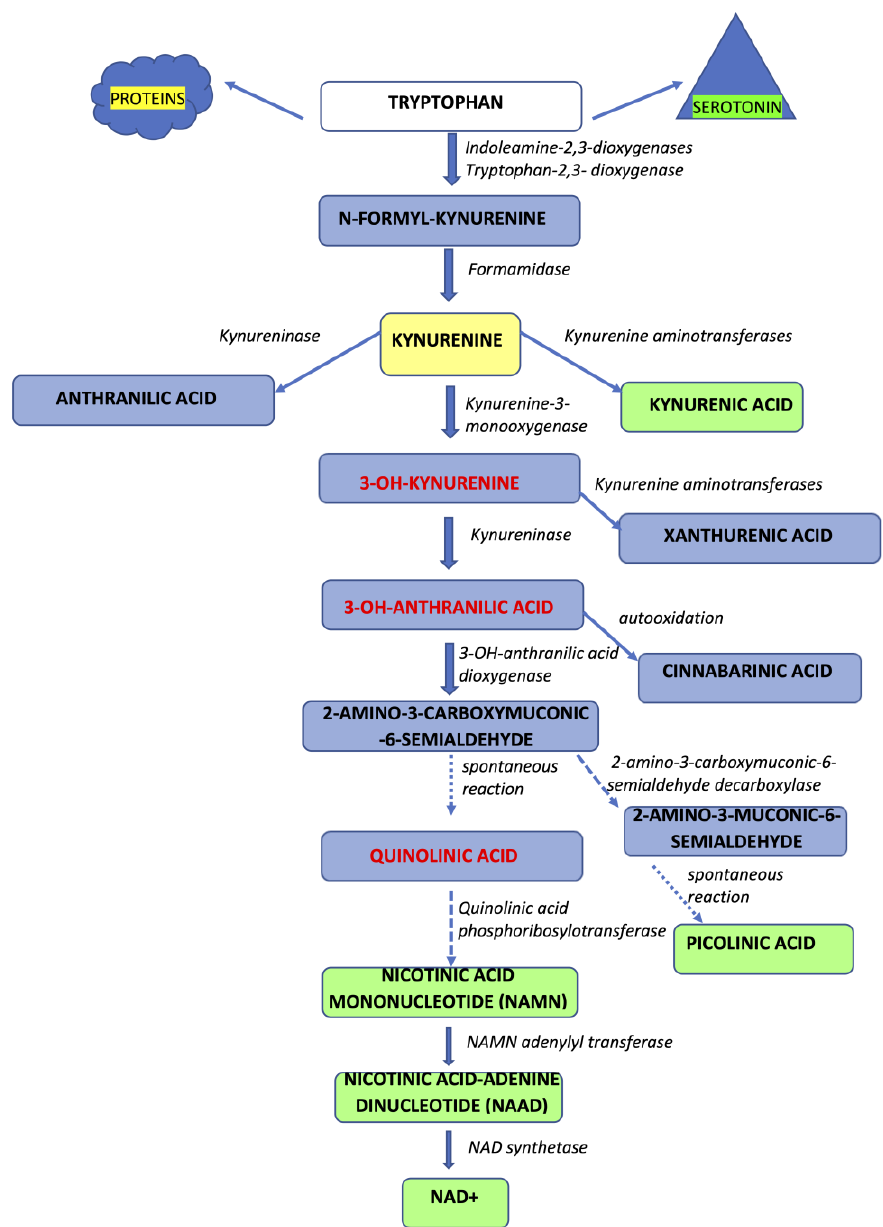
Figure 1. The scheme of tryptophan metabolism along the kynurenine pathway (KP). The majority of available serum tryptophan enters the KP. IDOs or TDO convert tryptophan into L-kynurenine, which is further catabolized by kynurenine aminotransferases to kynurenic acid, kynurenine-3- monooxygenase to 3-OH-L-kynurenine, or kynureninase to anthranilic acid. Kynurenine amino- transferases may convert 3-OH-L-kynurenine to xanthurenic acid or kynureninase to form 3-OH- anthranilic acid. Further, 3-OH-anthranilic acid is converted into quinolinic or picolinic acid by a series of enzymatic conversions.